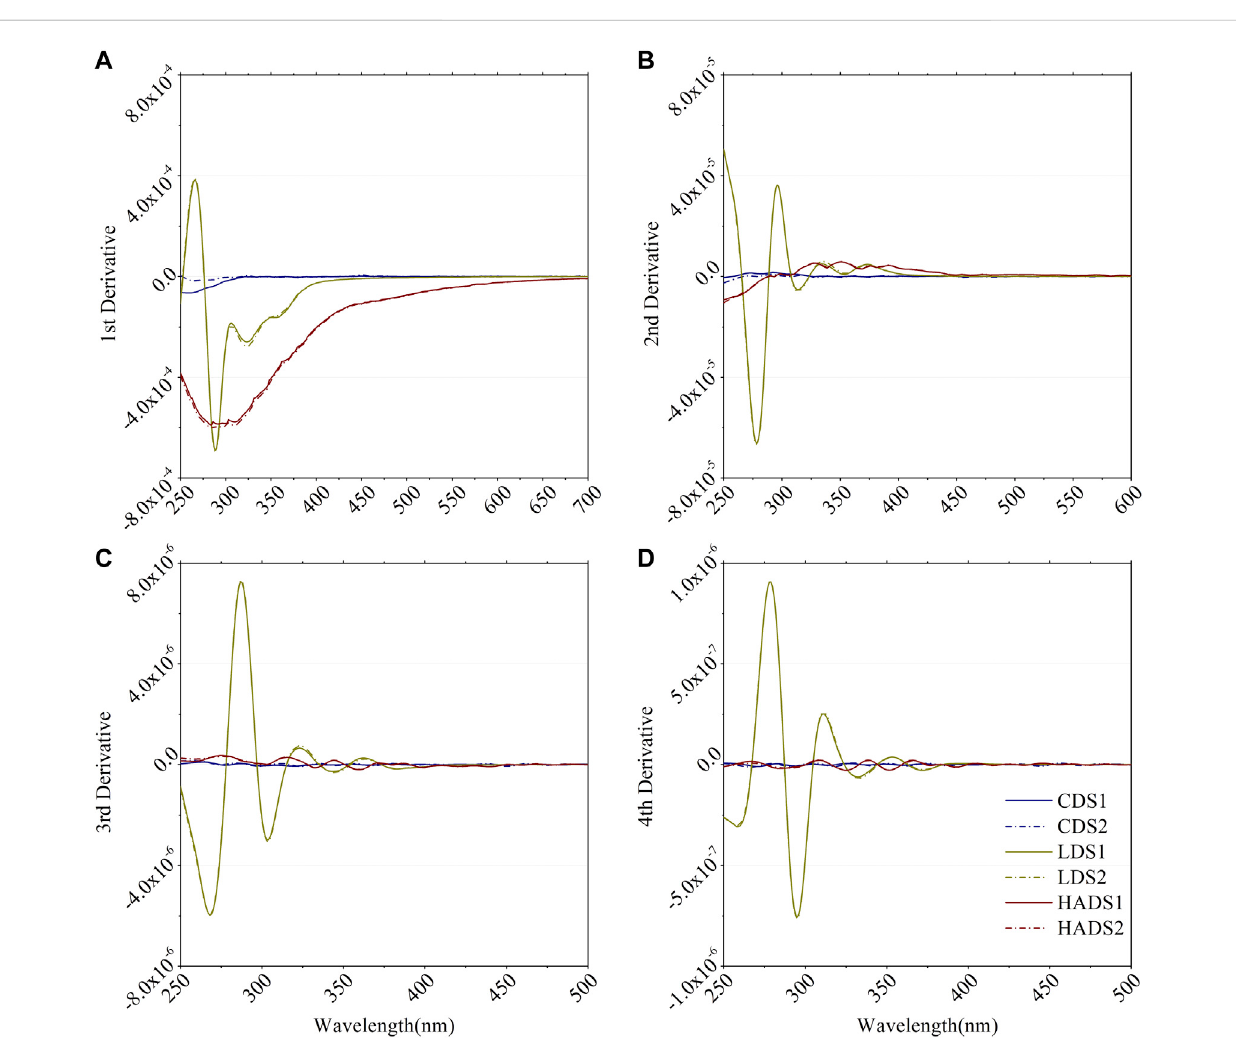
FIGURE 7 (A) 1st derivative, (B) 2nd derivative, (C) 3rd derivative and (D) 4th derivative of smoothed speci fi c absorbance spectra for blank and single component BCs in duplicate. CDS, LDS and HADS are cellulose-dissolved solution, lignin-dissolved solution and humic acid-dissolved solution respectively. 1 and 2 denote to the duplicated